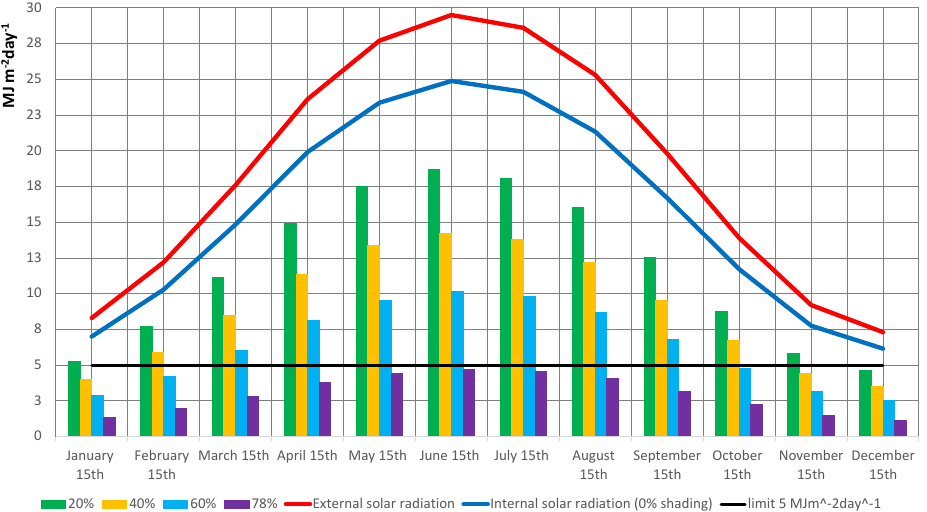
Figure 9. Levels of external and internal solar radiation under different levels of shading (0%, 20%, 40%, 60%, and 78%).